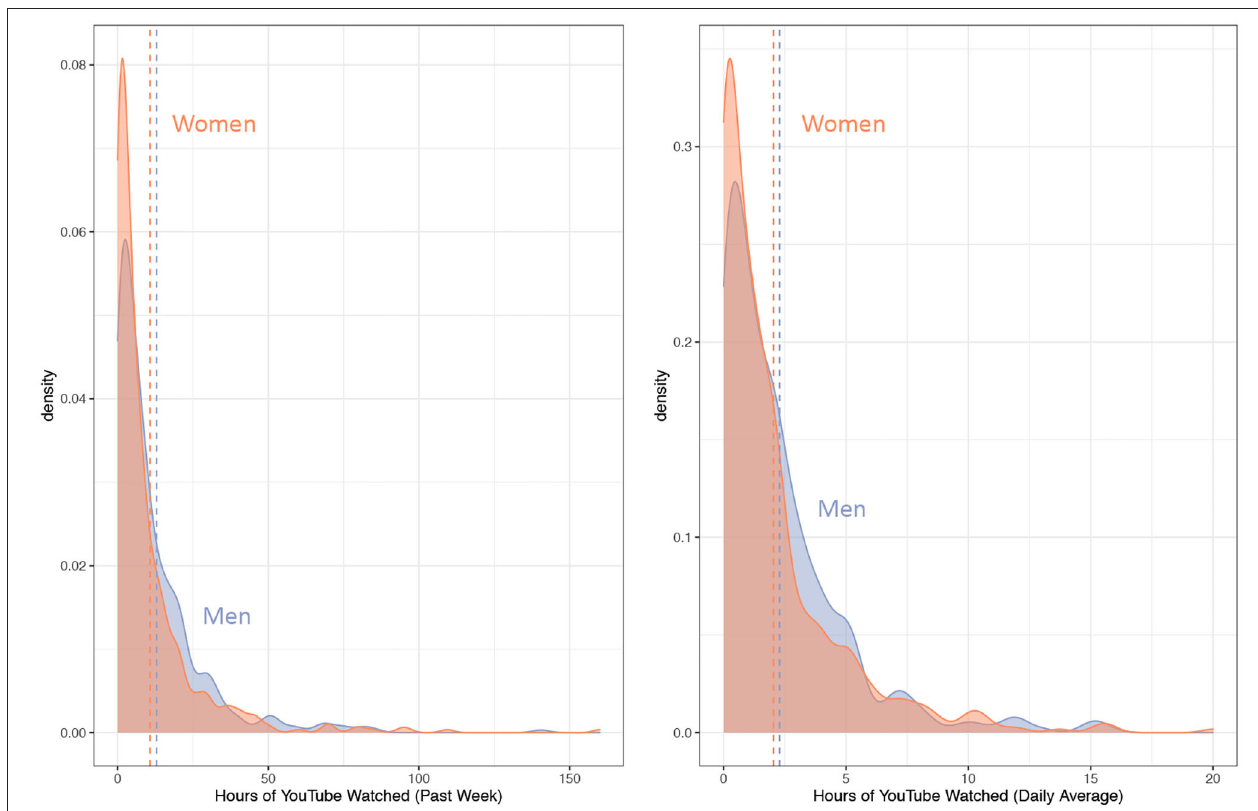
FIGURE 2 | Distribution of watch time for men and women. Figure on the left is the number of hours watched in the past seven days (past week). Figure on the right is the number of hours watched on average each day (daily average). Dotted lines represent the average for each gender. younger participants reported greater use of the platform